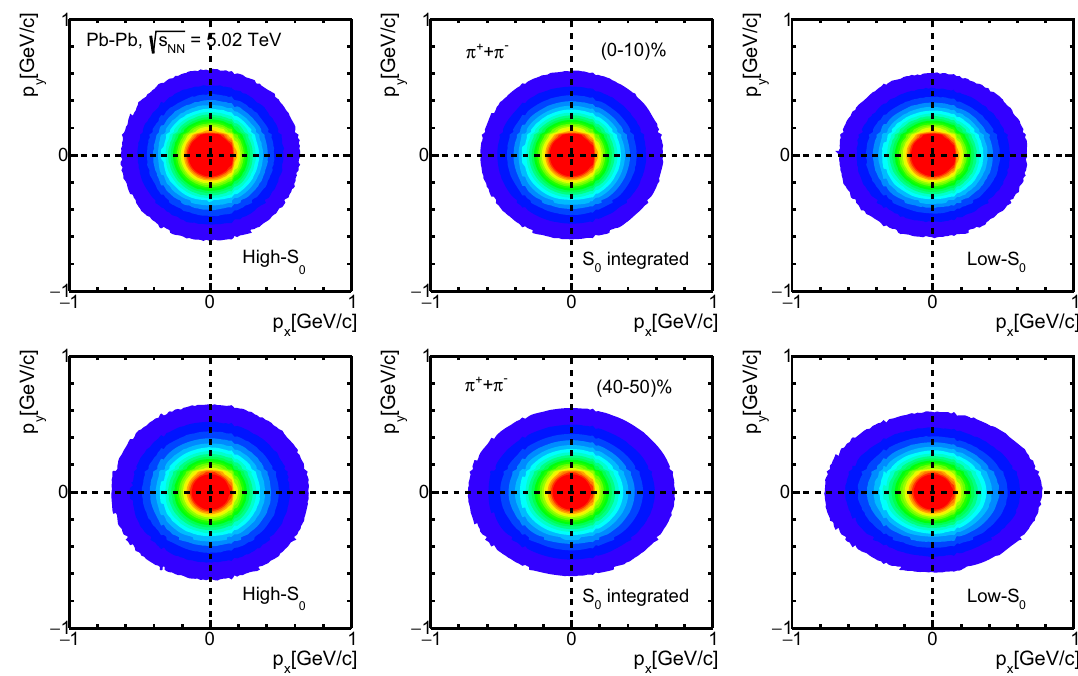
Fig. 1 Transverse momentum space correlation ( p y vs. p x ) for π + + π − in different spherocity classes for (0–10)% (top) and (40–50)% (bottom) √ s NN = 5 . 02 TeV in AMPT model central Pb+Pb collisions at